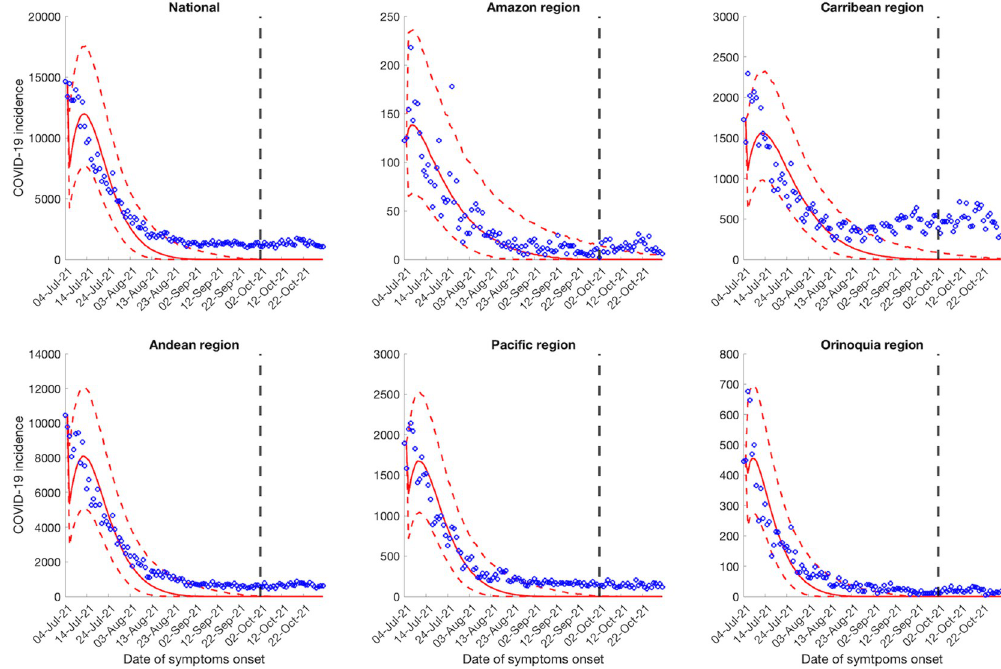
Fig 3. 30-days ahead forecasts of the national and regional COVID-19 epidemic curves in Colombia by calibrating the GLM model from July 4, 2021 to October 1, 2021. The blue circles correspond to the data points; the solid red line indicates the best model fit, and the red dashed lines represent the 95% prediction interval. The vertical black dashed line represents the time of the start of the forecast period.